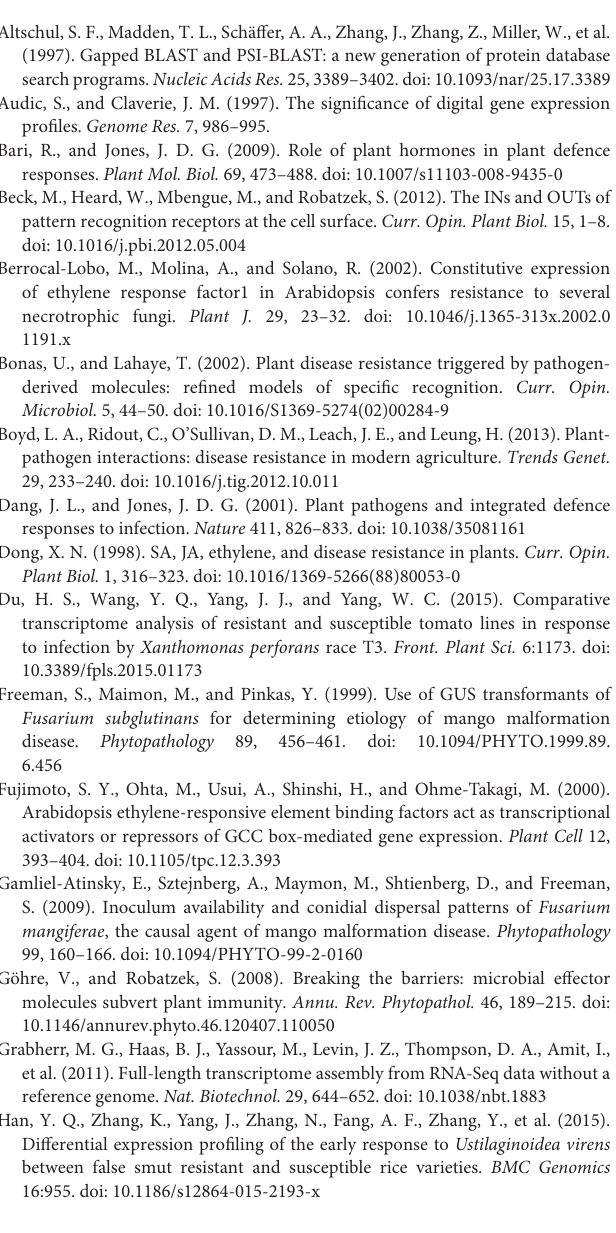
Figure S2 | Frequency distribution of Unigene lengths in Illumina HiSeq TM 2000 sequencing data. Figure S3 | Statistical comparison 4 database gene Venn diagram. Figure S4 | COG annotations of putative proteins in